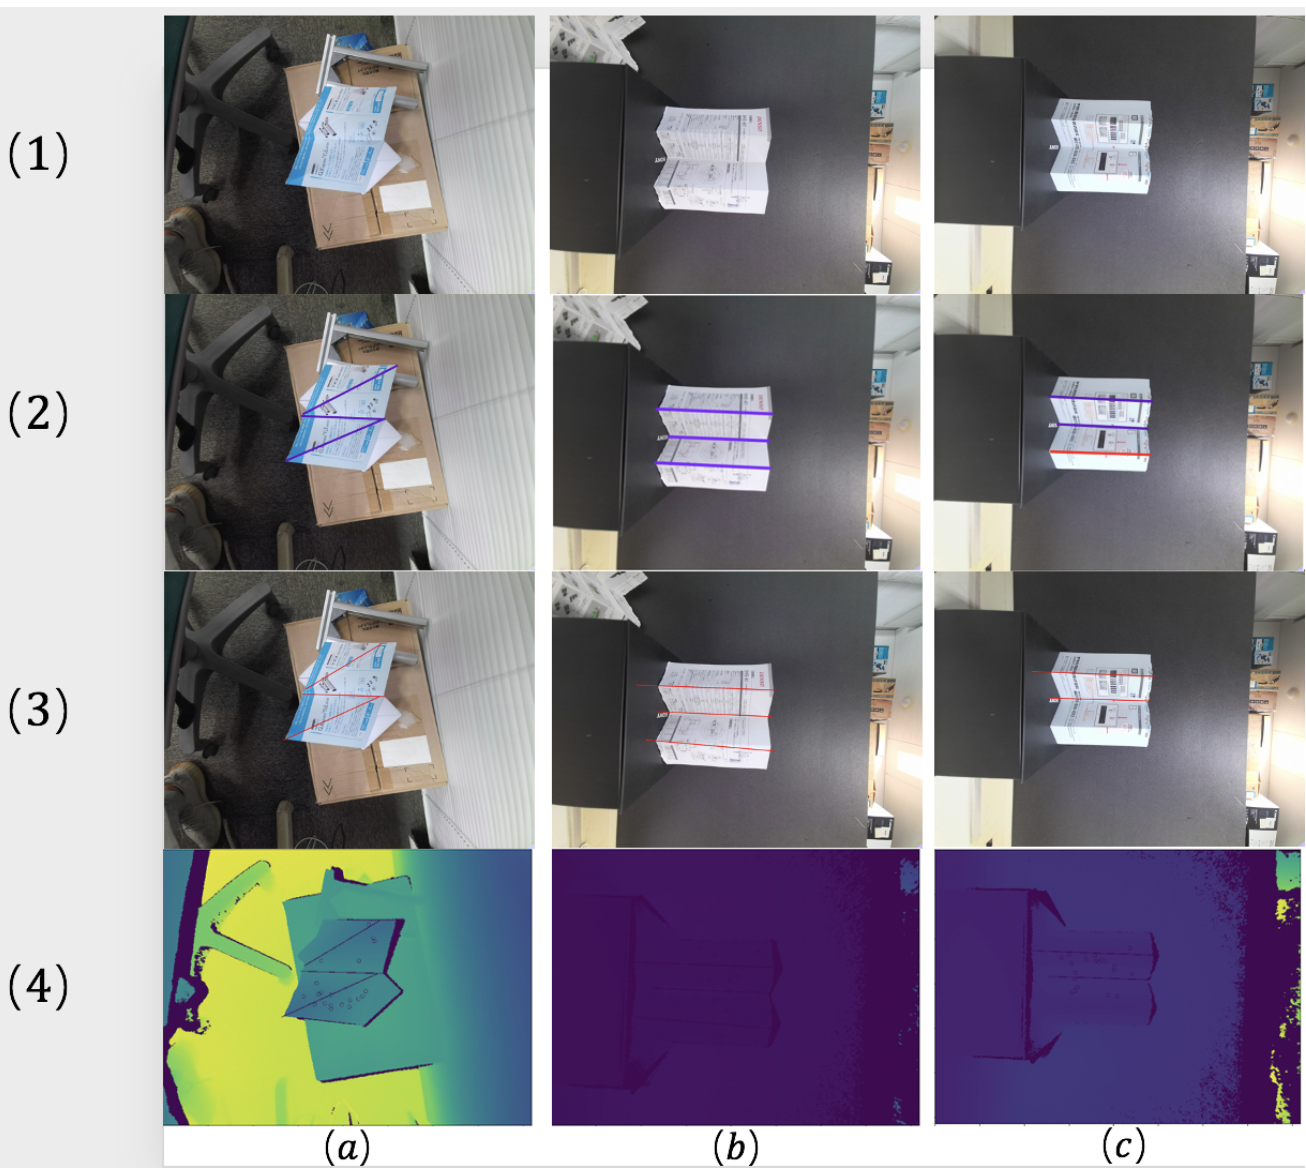
Figure 18. Three kinds of deformed paper ( a – c ): ( 1 ) RGB image; ( 2 ) ground truth of bending line; ( 3 ) projection of 3D bending line on the 2D RGB image; ( 4 ) projection of 3D bending line on 2D depth